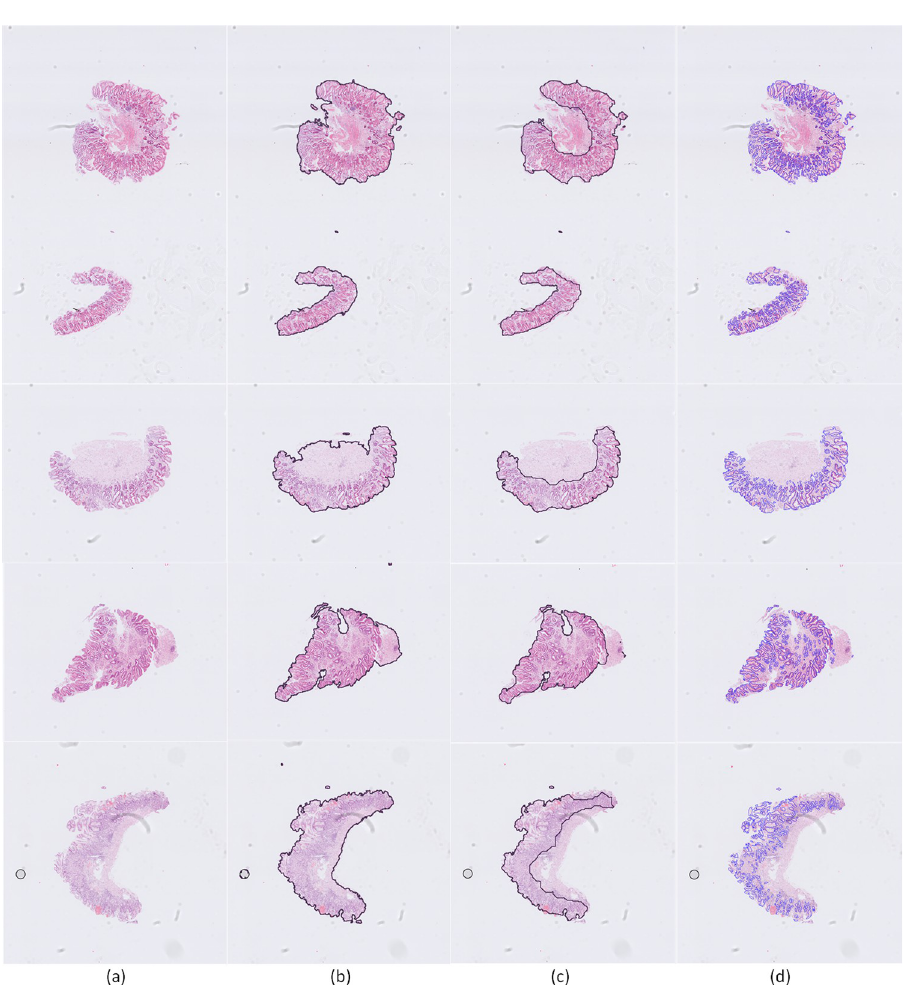
Fig 6. Qualitative results of the segmentation of the gastric tissue, gastric mucosa and gastric glands: a) input 10x H&E-stained image, b) gastric tissue segmentation, c) gastric mucosa identification, d) gastric glands detection.